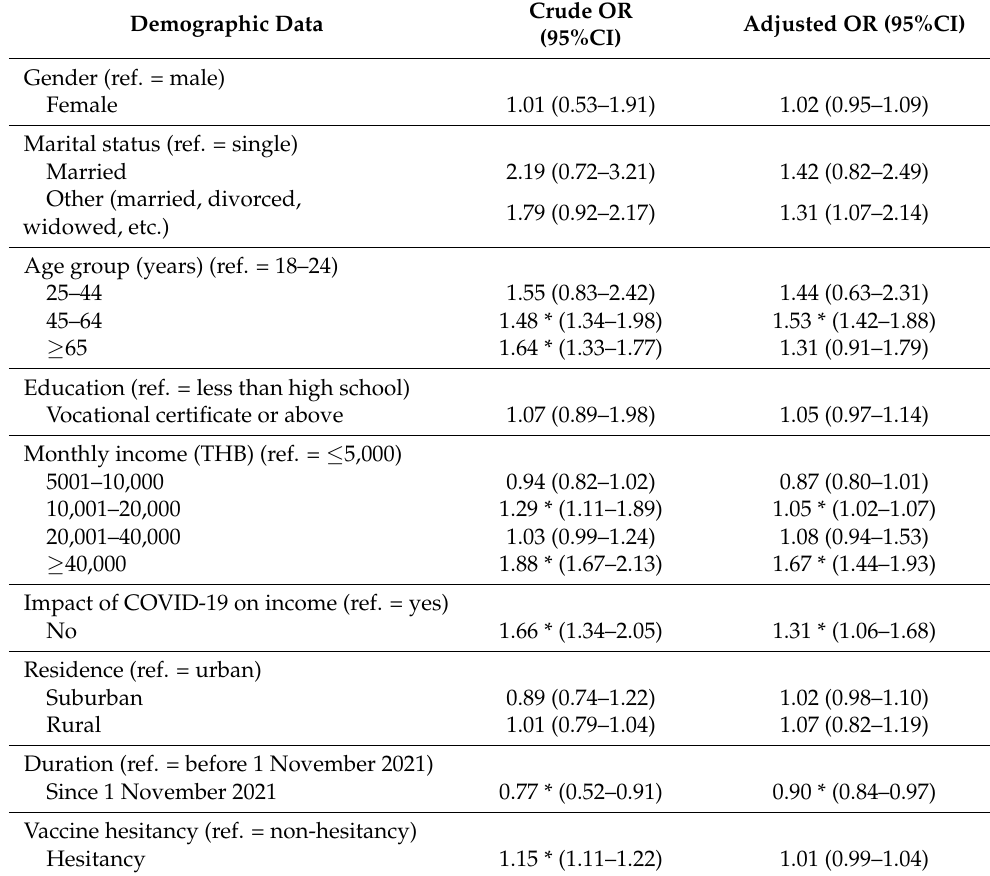
Table 6. Logistic regression model predicting willingness to pay for the COVID-19 vaccine (n = 650). Demographic